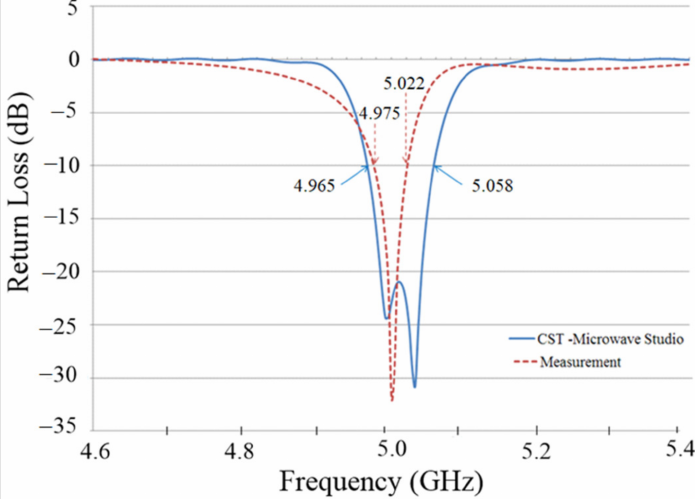
Figure 15. Comparison between the measured and the simulated return losses. Although the measured return loss seemed to be a narrower bandwidth over the simulated outcomes, these discrepancies were due to the following: the fabrication toler- ances of the related physical parameter, the position of the cavity-backed slot coupling, the uncertainty of the thickness and/or the dielectric constant of the FR4 substrate, and the effects of improper soldering of the cavity and SMA connectors that are used in material characterization and microwave devices [31]. Figure 16a,b showed the measured and simu- lated values in the E-plane (y-z plane) and H-plane (x-y plane) at 5.0 GHz. with far-field normalized radiation patterns. These radiation patterns of the proposed antenna were measured with the HP 8722D Network Analyzer in an anechoic chamber. The obtained radiation patterns have directional radiations in the E-plane and H-plane of half-power beam widths around ± 65 ◦ and ± 40 ◦ , respectively. The maximum directive gain of the proposed antenna computed by applying the Friis Transmission Equation [32] was approx- imately 5.6 dB. The measured front-to-back ratios in comparison with the simulated one of E-plane radiation patterns were 30 and 16 dB, respectively while the simulated ones of H-plane radiation patterns were 22 and 14 dB,